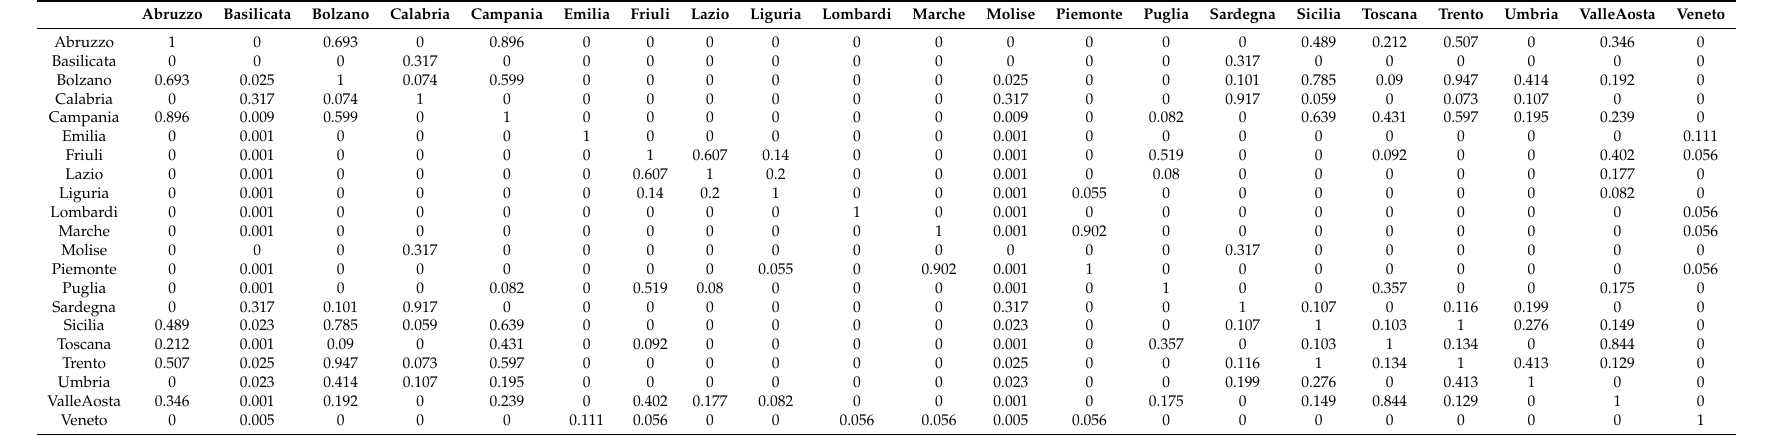
Table A46. Similarity values of Deceased network in the third